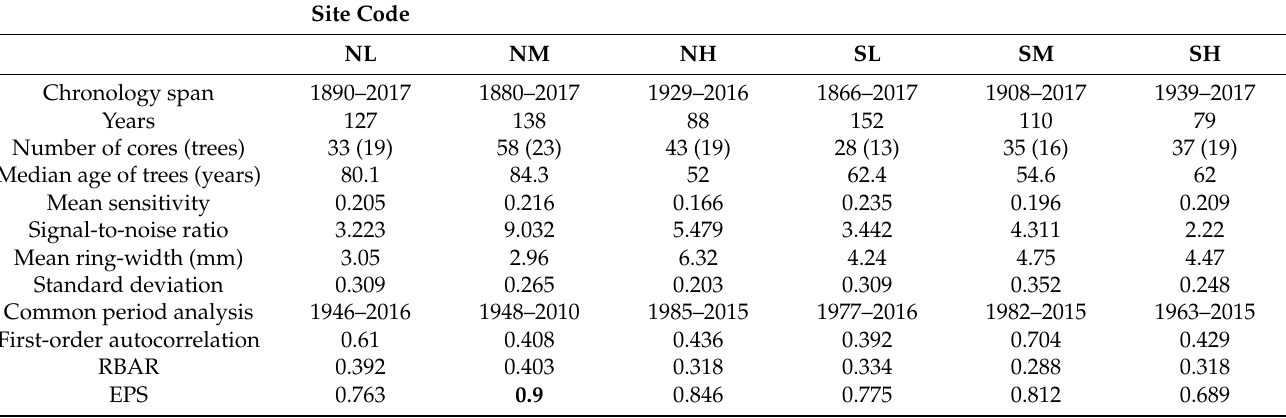
Table 2. Dendrochronological parameters of Abies jaliscana ring-width chronologies in the mountains of western Jalisco,